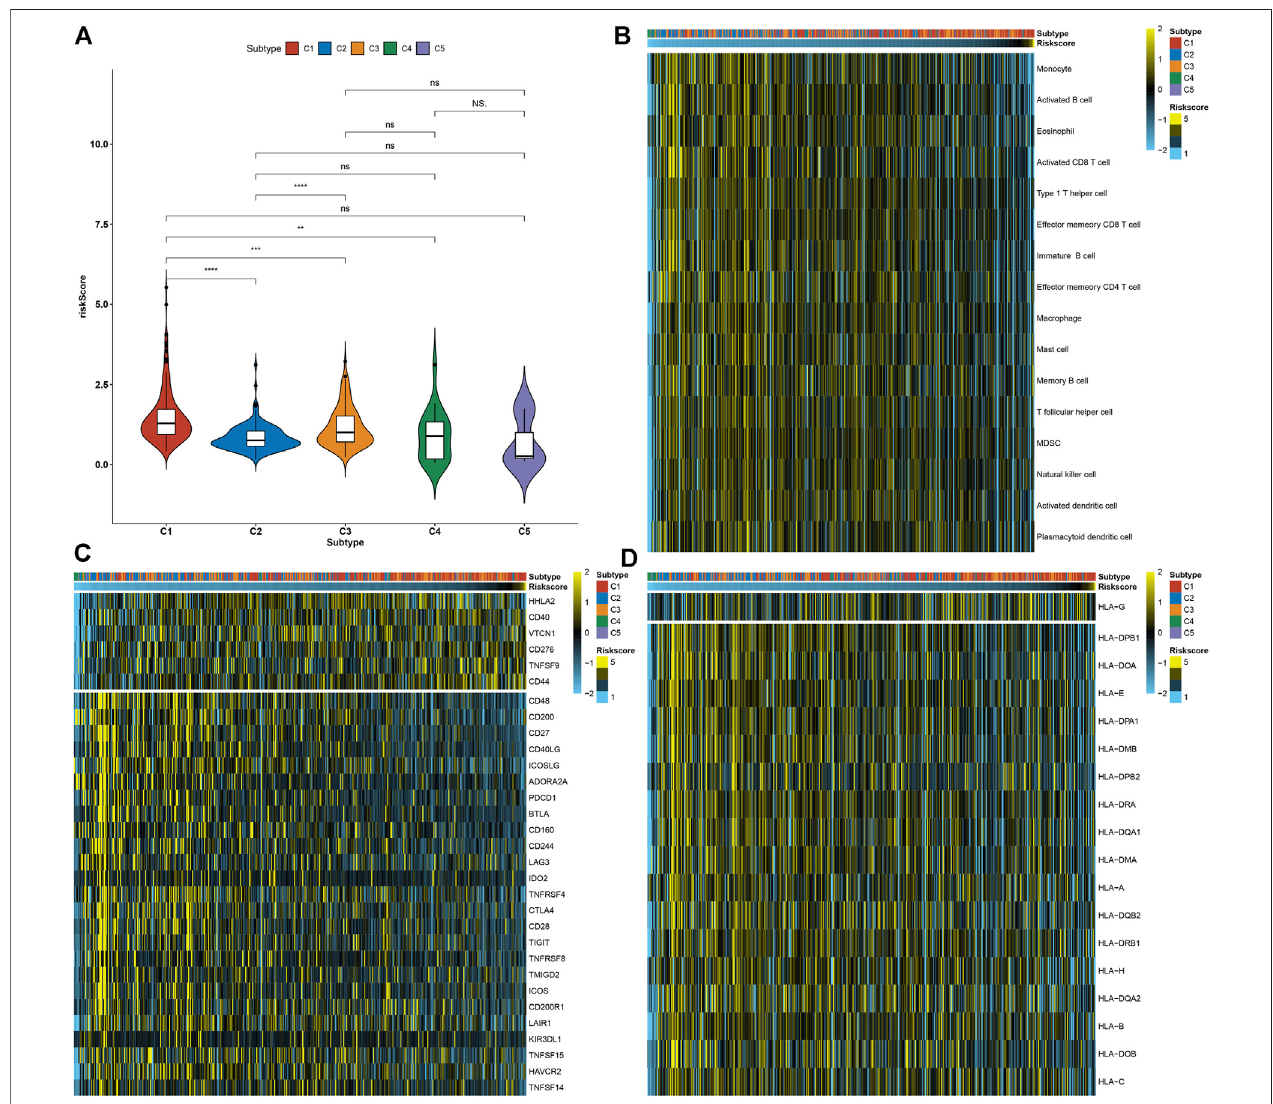
FIGURE 7 | Necroptosis-relevant risk model links with tumor immunogenicity for pancreatic cancer. (A) Distribution of the necroptosis-relevant risk score in fi ve necroptosissubtypes.Ns:notsigni fi cant;** p < 0.01;*** p < 0.001;and**** p < 0.0001. (B) Visualizationofthein fi ltrationsofimmunecellpopulationsinpancreaticcancer specimensorderedbythenecroptosis-relevantriskscore. (C,D) Quanti fi cationofthemRNAexpressionof (C) immunecheckpointsand (D) HLAmoleculesinpancreatic cancer specimens ordered by the necroptosis-relevant risk